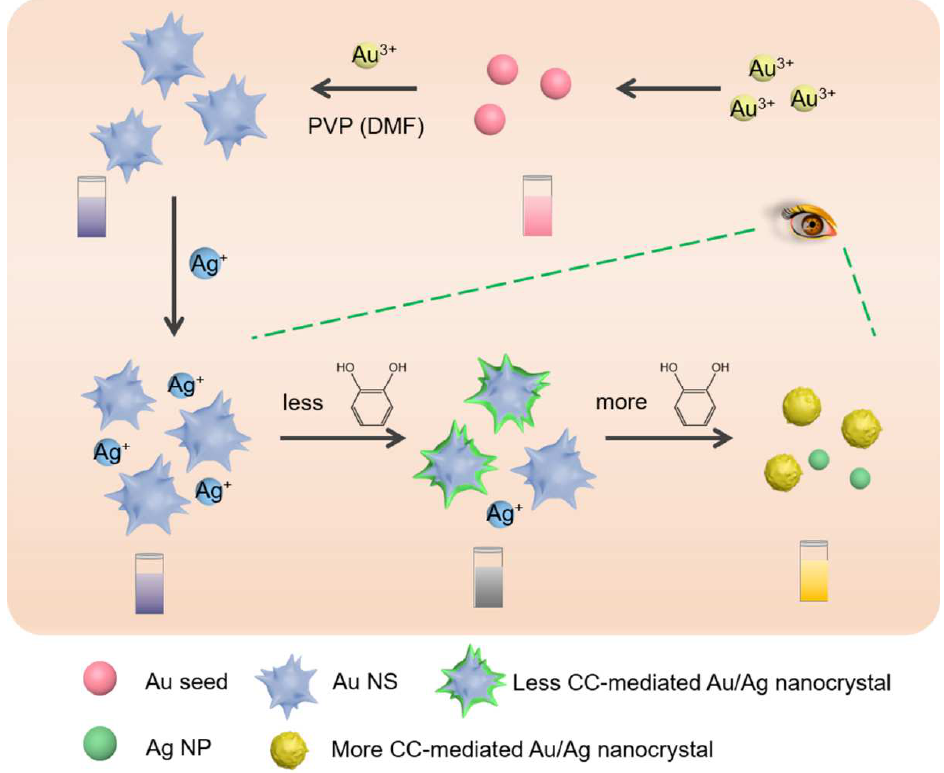
Scheme 1. Schematic illustration of the plasmonic colorimetric sensor for the detection of CC.